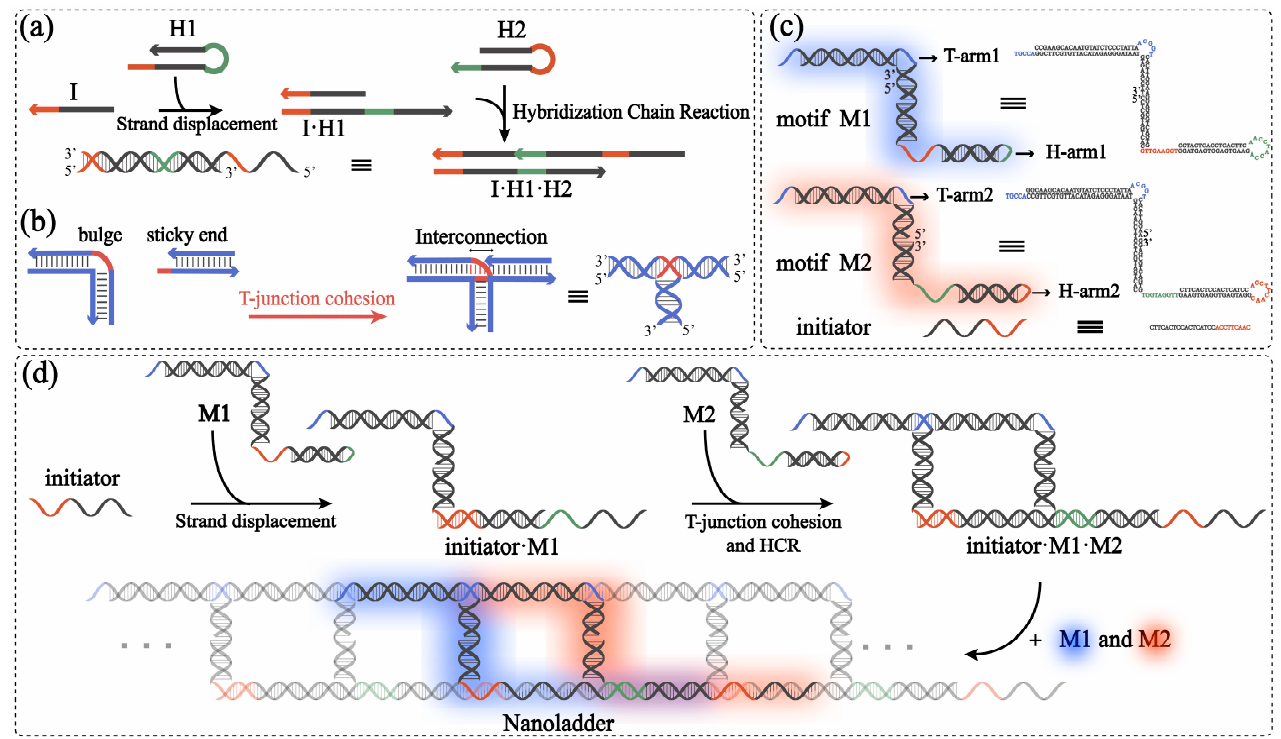
Figure 2. ( a ) Schematic representation of hybridization chain reaction (HCR). ( b ) Schematic repre ‐ sentation of T ‐ junction. ( c ) Schematic illustrations of structures ( left ), and sequences of motif M1, motif M2, and initiator ( right ). ( d ) Simple self ‐ assembly schematic illustration of DNA nanoladders. One motif M1 and one motif M2 are highlighted.